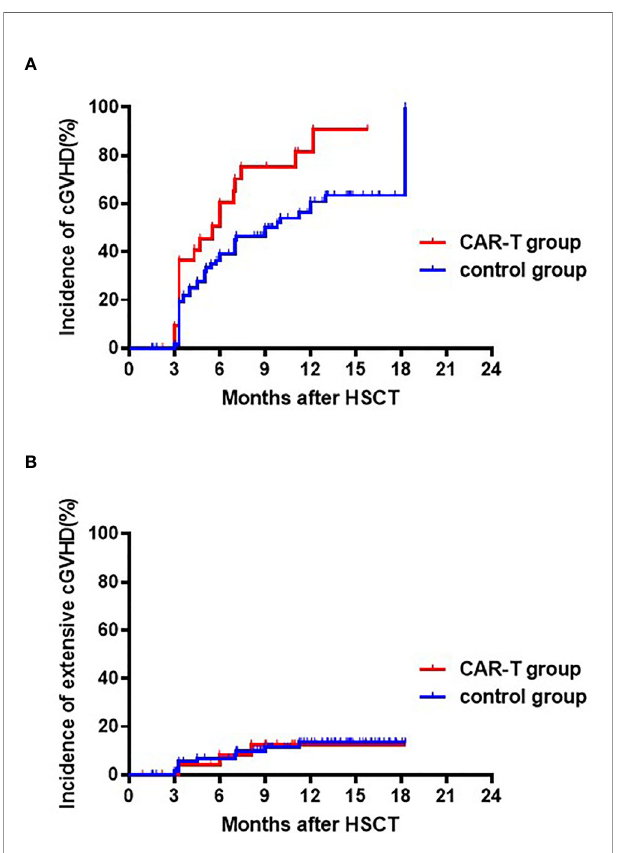
FIGURE 4 | Cumulative incidences of relapse (CIR) and NRM. (A) Cumulative incidence of relapse: CAR T-cell group: 4-year CIR of 11.1% (95% CI: 10.3, 11.9%) vs. chemotherapy group: 12.8% (95% CI:12.6, 13.0%) (p=0.84). (B) Cumulative incidence of NRM: CAR T-cell group: 4-year NRM of 18.7% (95% CI:17.5, 19.9%) vs. chemotherapy group: 4-year NRM of 23.1% (95% CI:22.7, 23.5%);